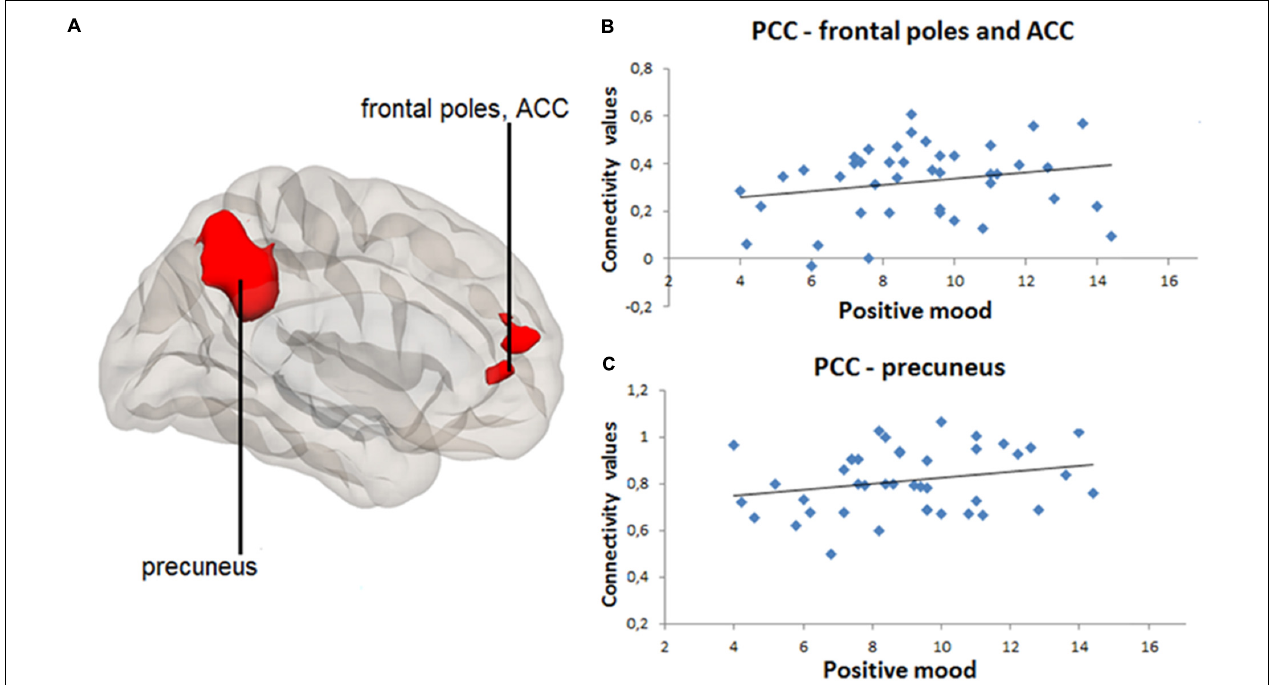
FIGURE 3 | Positive correlation between daily positive mood and resting-state connectivity between posterior cingulate cortex (PCC) and frontal poles and anterior cingulate cortex (ACC), as well as between PCC and precuneus. PCC-based seed-to-voxel connectivity 3D map presented using CONN toolbox. (A) Right red cluster depicts frontal poles and ACC positively coupled with PCC. Left red cluster depicts precuneus positively coupled with PCC. (B) Scatter-plot for visual inspection illustrates the result from the extracted mean connectivity values of the right cluster within the default-mode network (DMN). Data was taken at peak Montreal Neurological Institute (MNI) coordinates: 2, 56, 12; k = 437; cluster p FWE < 0.001. (C) Scatter-plot for visual inspection illustrates the result from the extracted mean connectivity values of the left cluster within the DMN. Data was taken at MNI coordinates: –10, –50, 38; k = 1980; cluster p FWE <